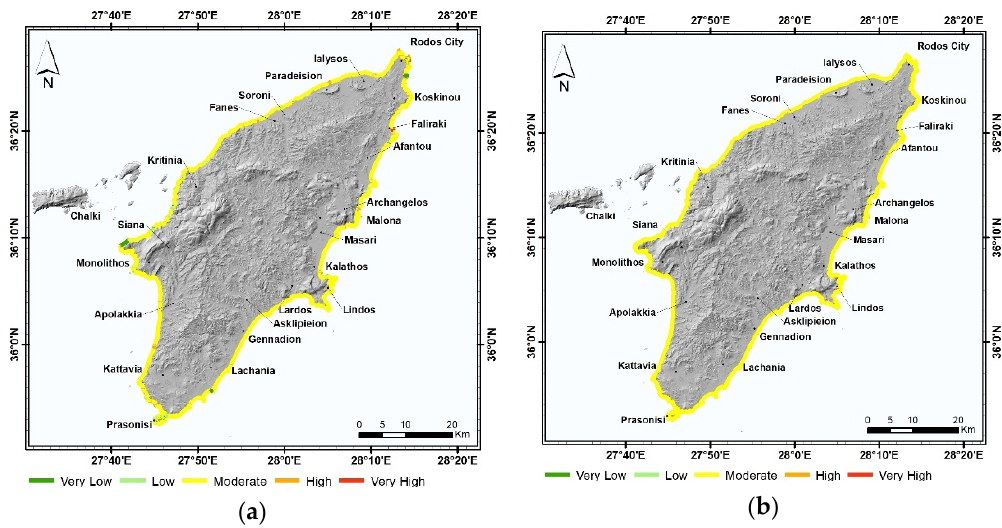
Figure 8. Evaluation of the relative coastal vulnerability due to the mean shoreline displacement rate in Rhodes Island: ( a ) the current situation and ( b ) condition projected to 2100.